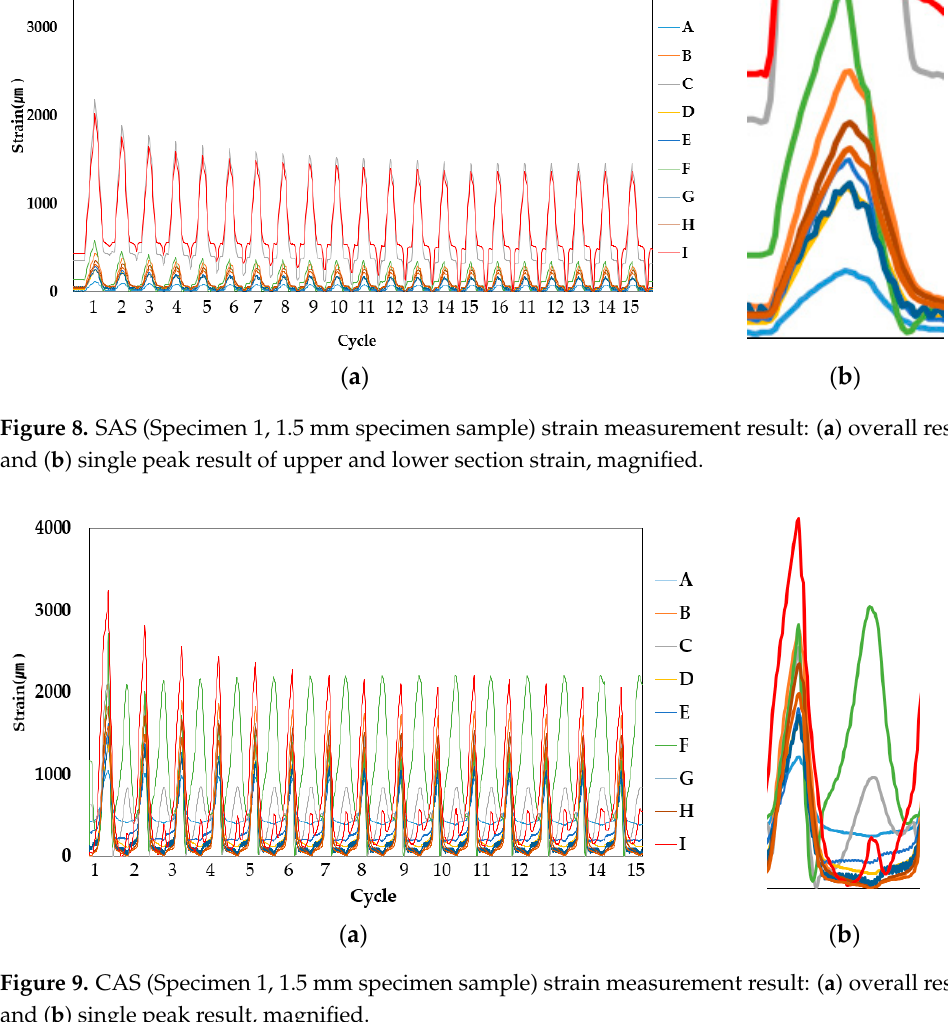
Figure 9. CAS (Specimen 1, 1.5 mm specimen sample) strain measurement result: ( a ) overall result and ( b ) single peak result, magnified.